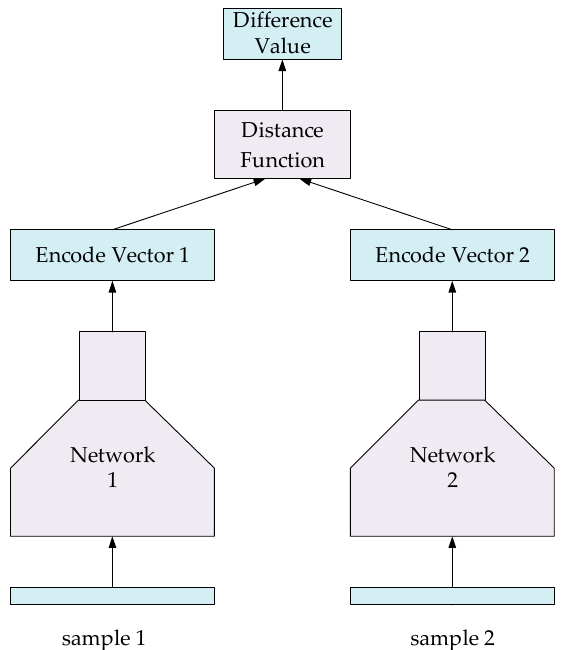
Figure 15. Structural diagram of the Siamese network. The network consists of two coding networks with common parameters and a distance function. The input of the network is a pair of sign language samples, and the output of the network is to measure the distance between the two samples. Two input samples of the model are first fed into two coding networks, which share the same structure and the same parameters. After passing through the coding network, the data of the two samples are mapped to a multi-dimensional Euclidean space and generate two coding vectors with 64 dimensions. These two vectors are passed into a distance function to calculate the distance between them. The encoding network is divided into two stages: feature extraction and feature encoding. In the feature extraction stage, we selected the same structure of the classification model.